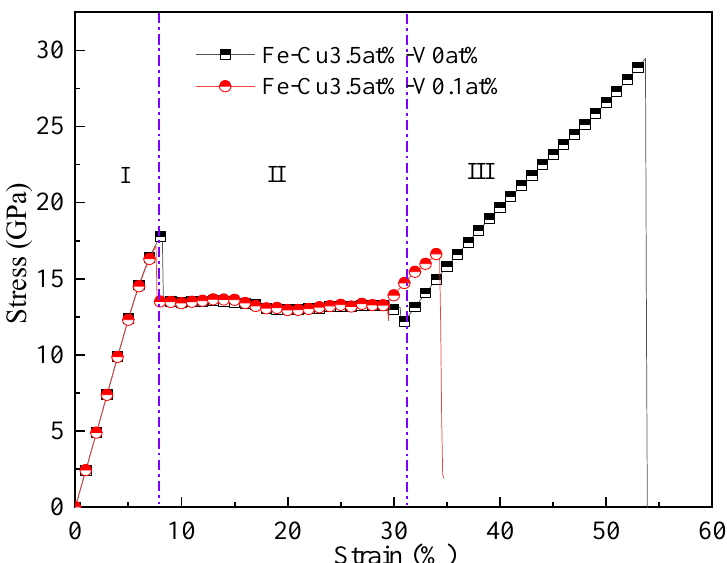
Figure 8. Stress – strain diagram of the Fe-3.5at%Cu-0at%V and Fe-3.5at%Cu-0.1at%V alloys after aging at 1050 K for 200 ns. I is the elastic deformation stage; II is the plastic deformation stage; III is the strain hardening stage.